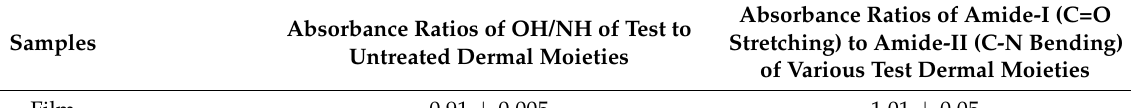
Figure 8. ATR-FTIR spectra of dermis of ( a ) control skin, skin treated by ( b ) film, ( c ) nanoparticles, ( d ) film and nanoparticle group. Table 4. Absorbance ratios of various regions.